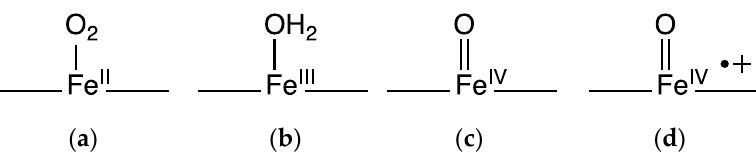
Figure 4. Oxygen species in hemoproteins: dioxygen bound ( a ); met form in globins or resting enzyme state in peroxidases ( b ); compound II ( c ) and compound I ( d ).